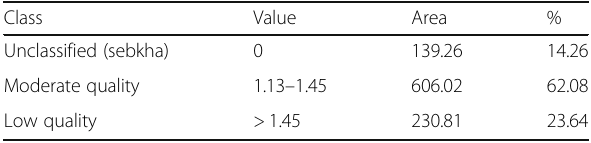
Table 9 Spatial distribution of climate quality index classes Table 10 Spatial distribution of soil quality index